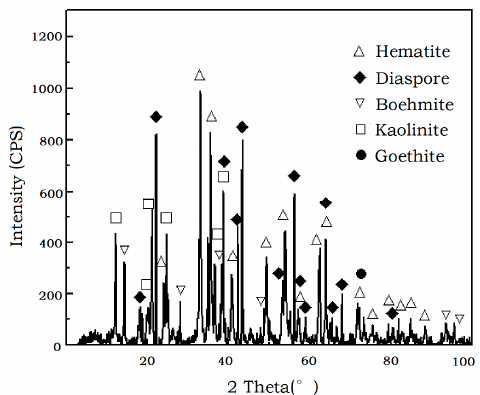
Figure 1. XRD patterns of ferric bauxite.